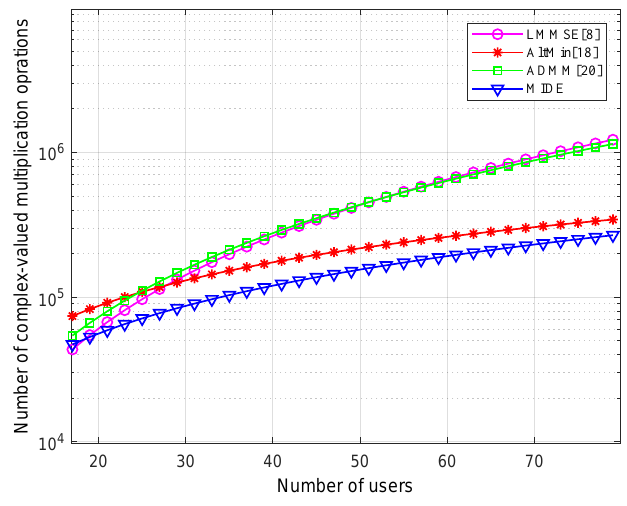
Figure 6. Computational complexity comparison against the number of